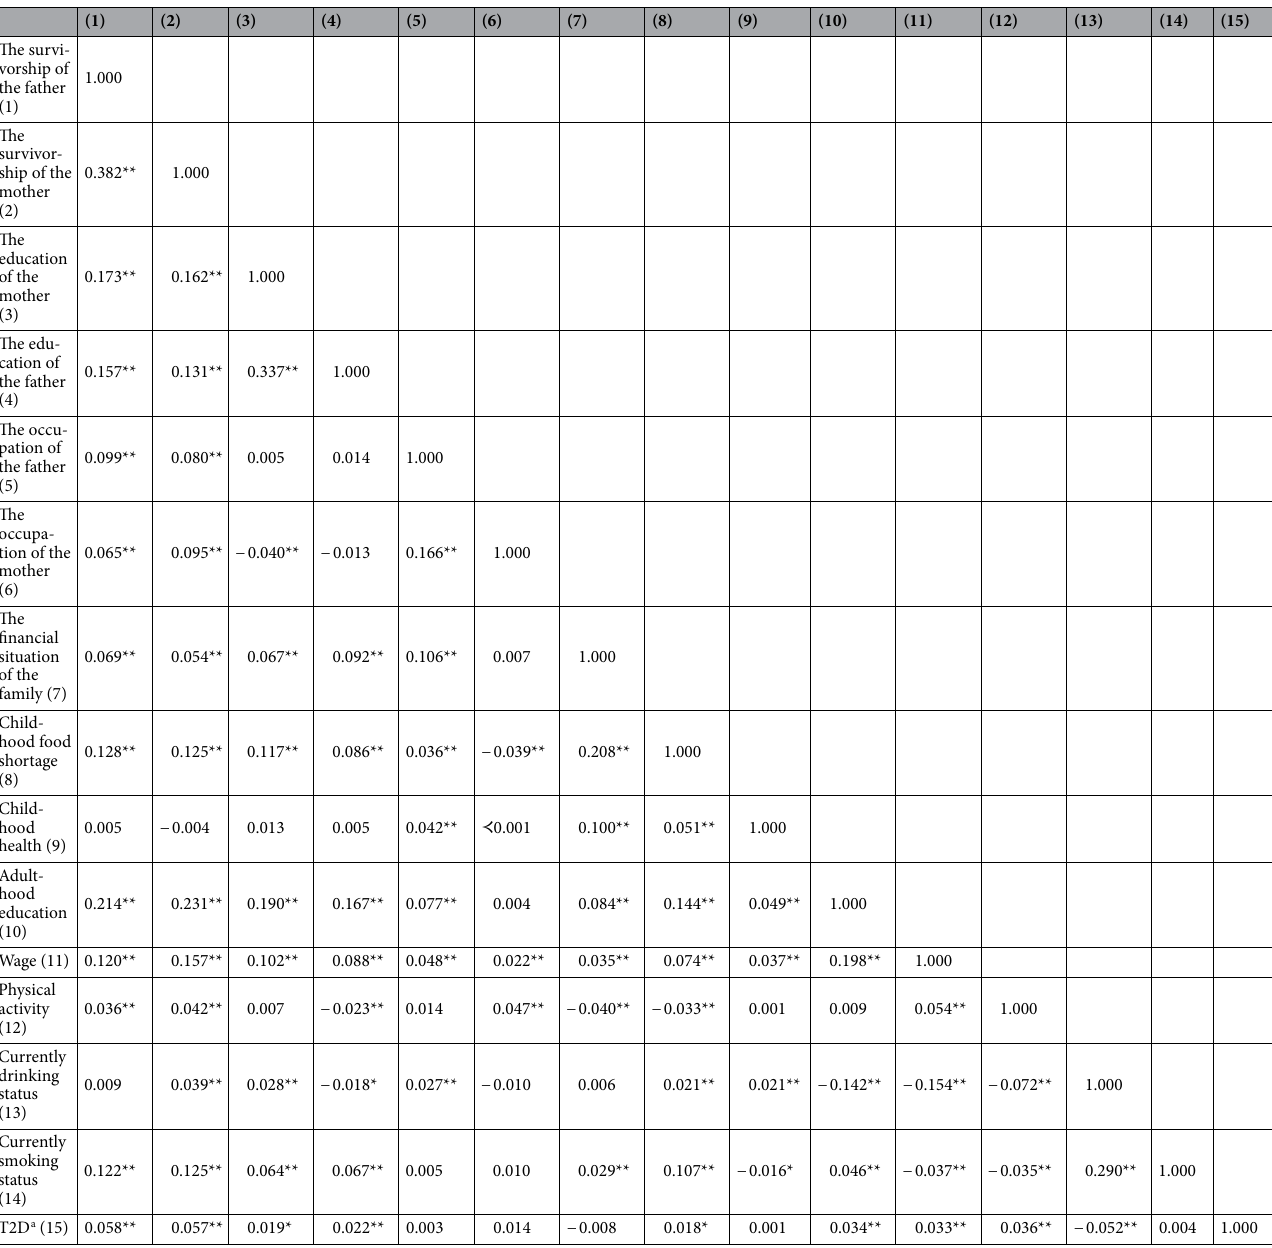
Table 2. Correlation matrix of the variables used in this study. a Type 2 diabetes.* p < 0.05; ** p <